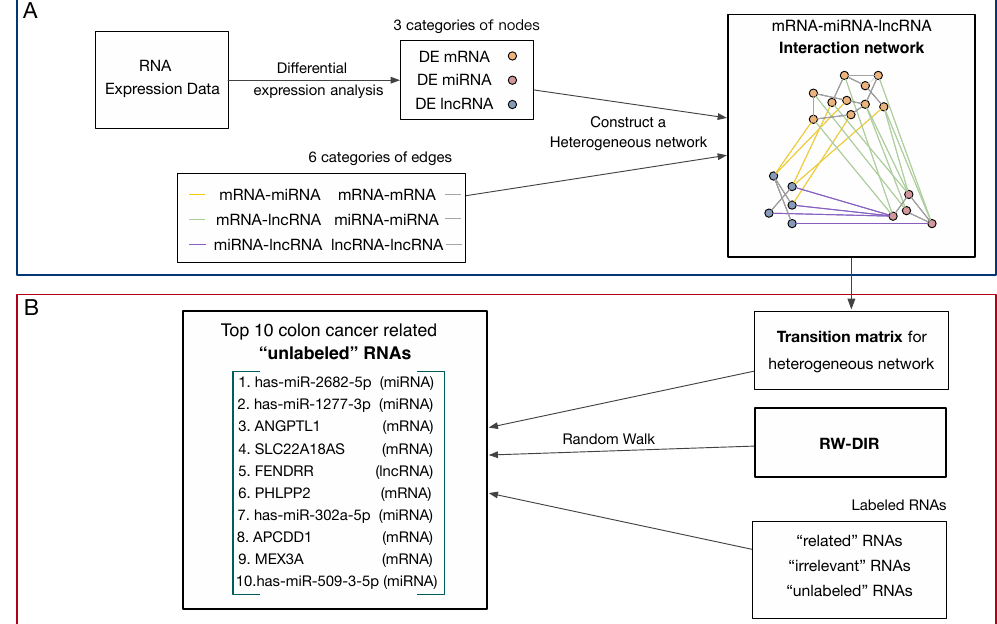
Figure 1. This is the workflow of this study. ( A ) Construct the mRNA-miRNA-lncRNA interaction network. ( B ) RW-DIR algorithm was applied to obtain the results of colon cancer-related